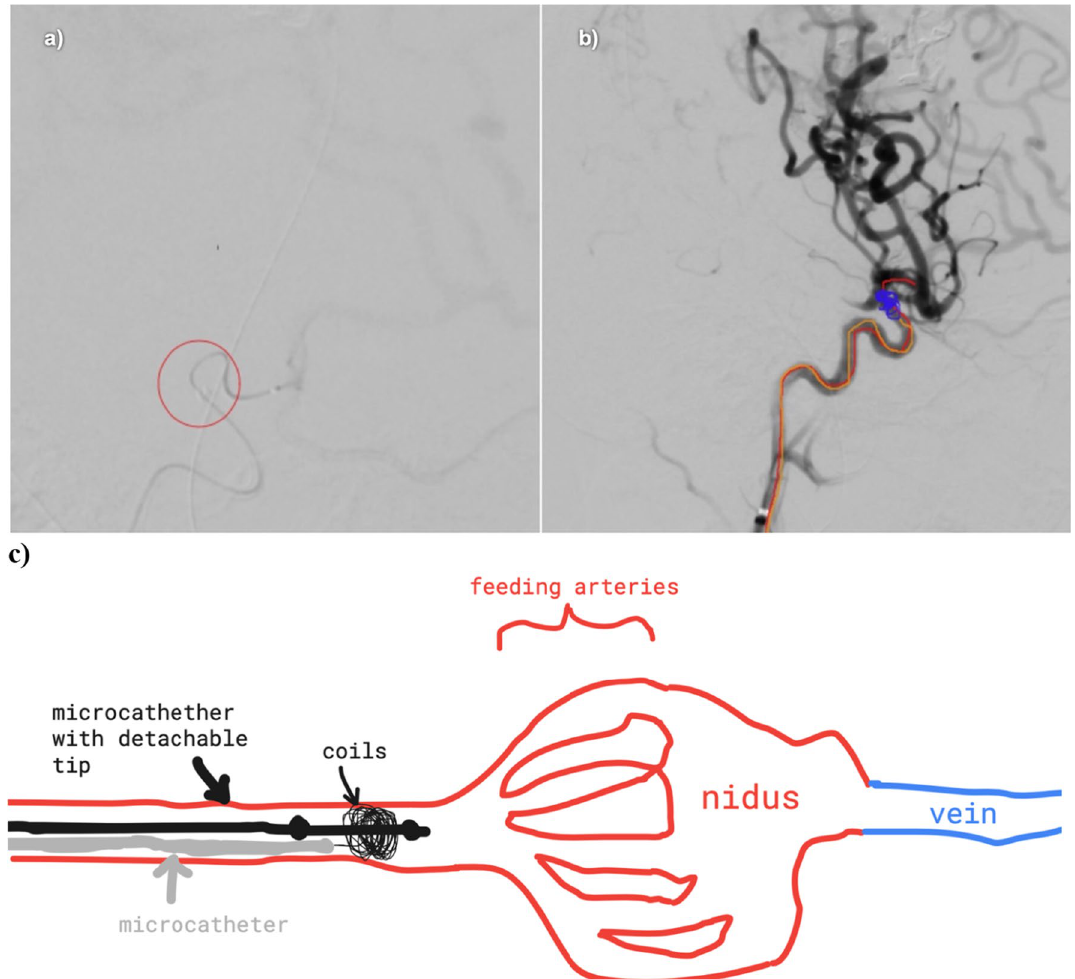
Fig. 5 Visualization of the pressure-cooker technique via intraarterial coiling-wedge. a Placement of the Kaneka coil wedge, AP view, b Illustration of the microcatheters and coil wedge placements, AP view, c Diagrammatic sketch of transarterial PCT